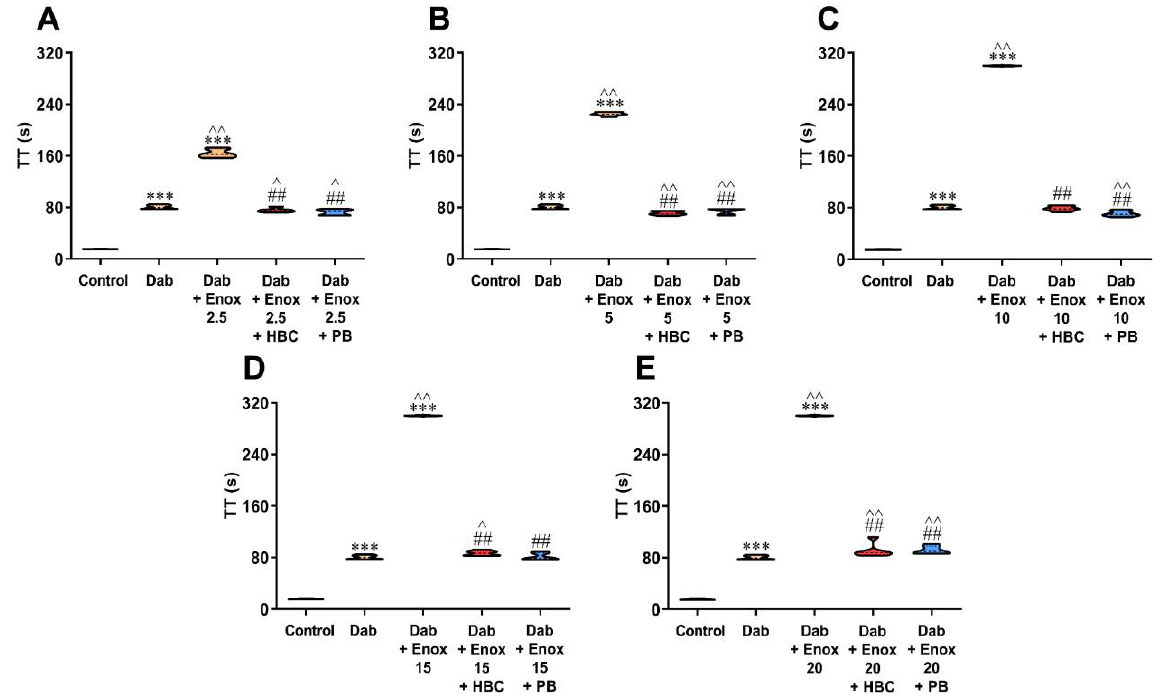
Figure 3. Inhibition of enoxaparin at a concentration of 2.5 ( A ), 5 ( B ), 10 ( C ), 15 ( D ), and 20 µg/mL ( E ) by HBC or polybrene at a concentration of 50 µg/mL during testing of dabigatran (50 ng/mL) anticoagulant activity by TT in human plasma. *** p < 0.001 vs. control; ^ p < 0.05, ^^ p < 0.01 vs. dabigatran; ## p < 0.01 vs. dabigatran with enoxaparin, Mann–Whitney test. The results are shown as violin plots with minimum and maximum values and analyzed with GraphPad Prism 8 software. Dab, dabigatran; Enox, enoxaparin; HBC, heparin-binding copolymer; PB, polybrene; TT, thrombin time.